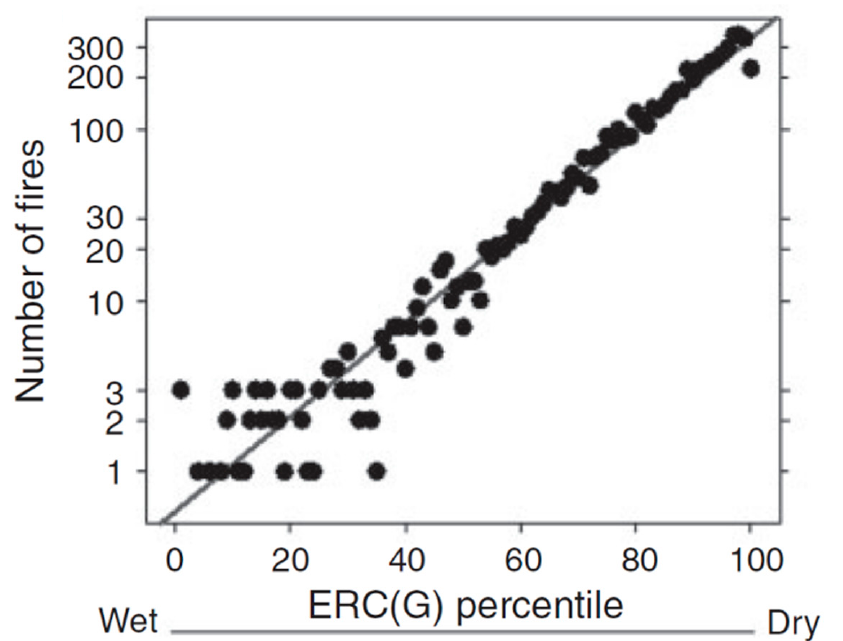
Figure 7. Number of fires in the Western US as a function of ERC(G) percentile (reproduced from Riley et al., 2013).